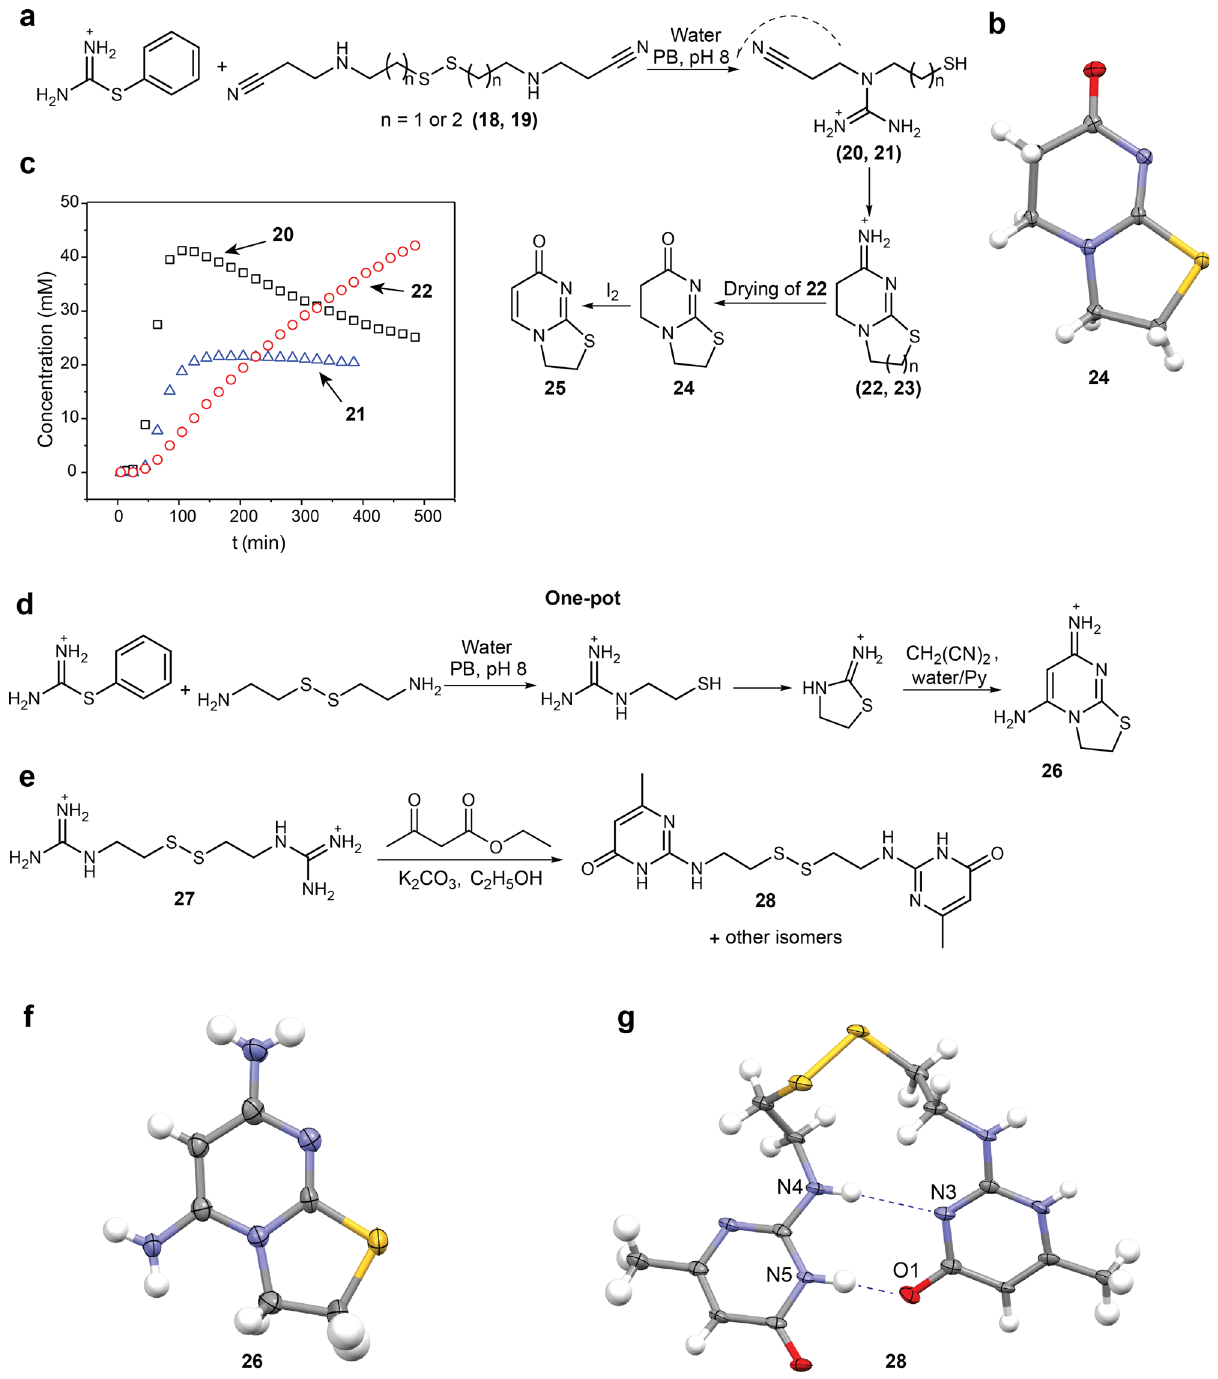
Fig. 4 Cyclization of guanidines formed in autocatalytic reactions. a Reactions of disul fi des 18 and 19 with 4 . Compounds 20 – 23 form spontaneously in water at pH 8. Compounds 24 – 25 form in the one-pot process. b An ORTEP diagram for X-ray structure of 24 (50% probability ellipsoids). c The kinetics of the reactions of 18 and 19 with 4 . Concentrations of 20 and 22 were monitored in the reaction of 18 by 1 H NMR. The concentration of 21 was monitored in a separate reaction with 19 . Reactions conditions: D 2 O, 1 M PB pH 8, 25 °C, [ 4 ] = 70 mM; [ 18 or 19 ] = 70 mM). d One-pot formation of the aminopyrimidine 26 from 4 , 17 , and malononitrile. e Scheme of the reaction between disul fi de 18 and ethyl acetoacetate. f An ORTEP diagram for X-ray structure of 26 (50% probability ellipsoids). g An ORTEP diagram for X-ray structure of 28 (50% probability ellipsoids). Hydrogen bonds are denoted as blue dashed